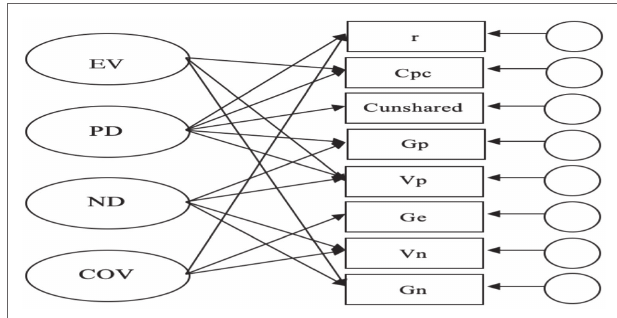
FIGURE 2 | Confirmatory factor analysis on indicators of emotional complexity.